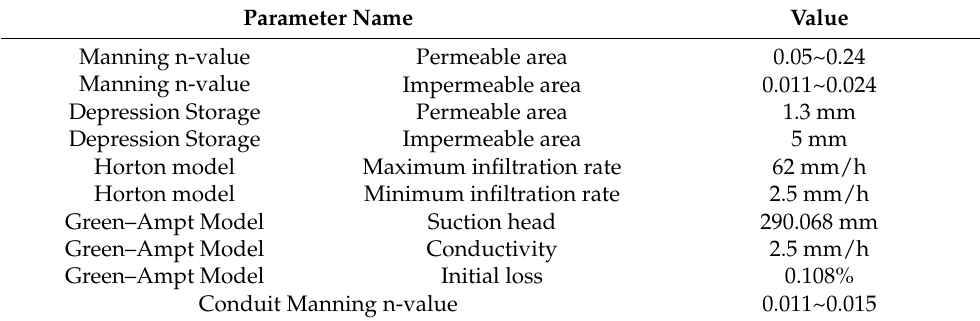
Table 1. SWMM model hydrological and hydraulic parameter settings.